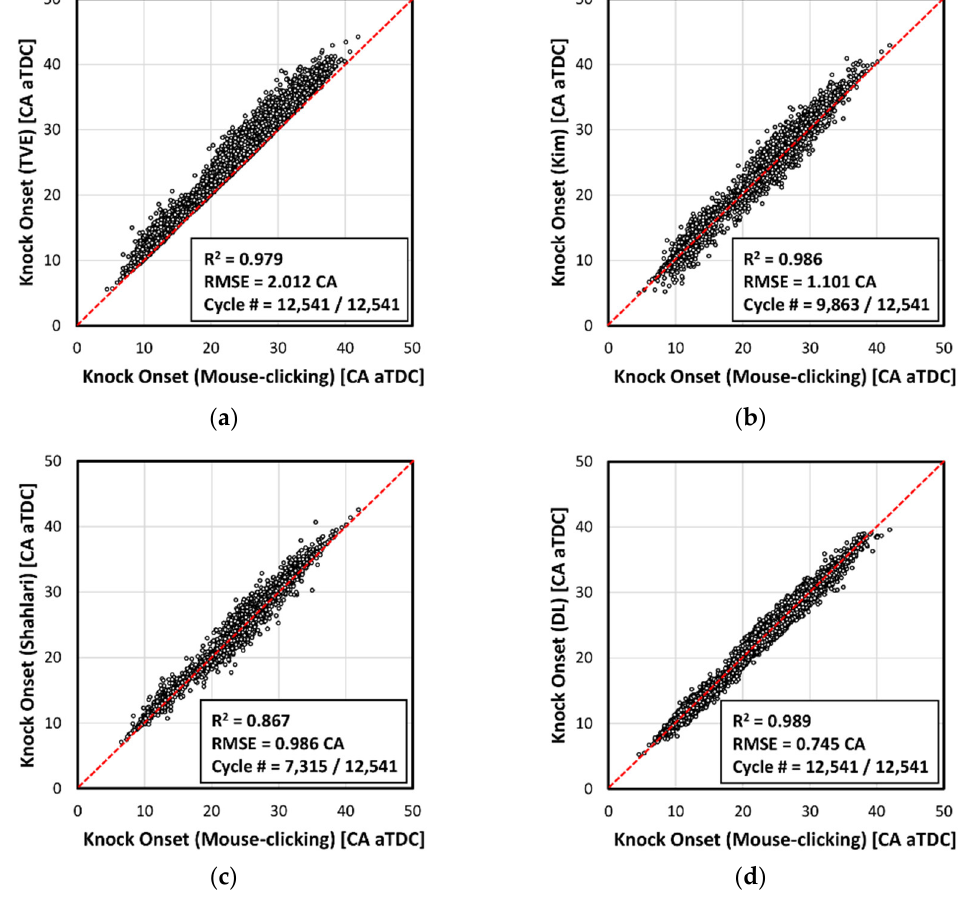
Figure 6. Various methods for KO determination: ( a ) TVE; ( b ) Kim; ( c ) Shahlari; ( d ) Smart KO model